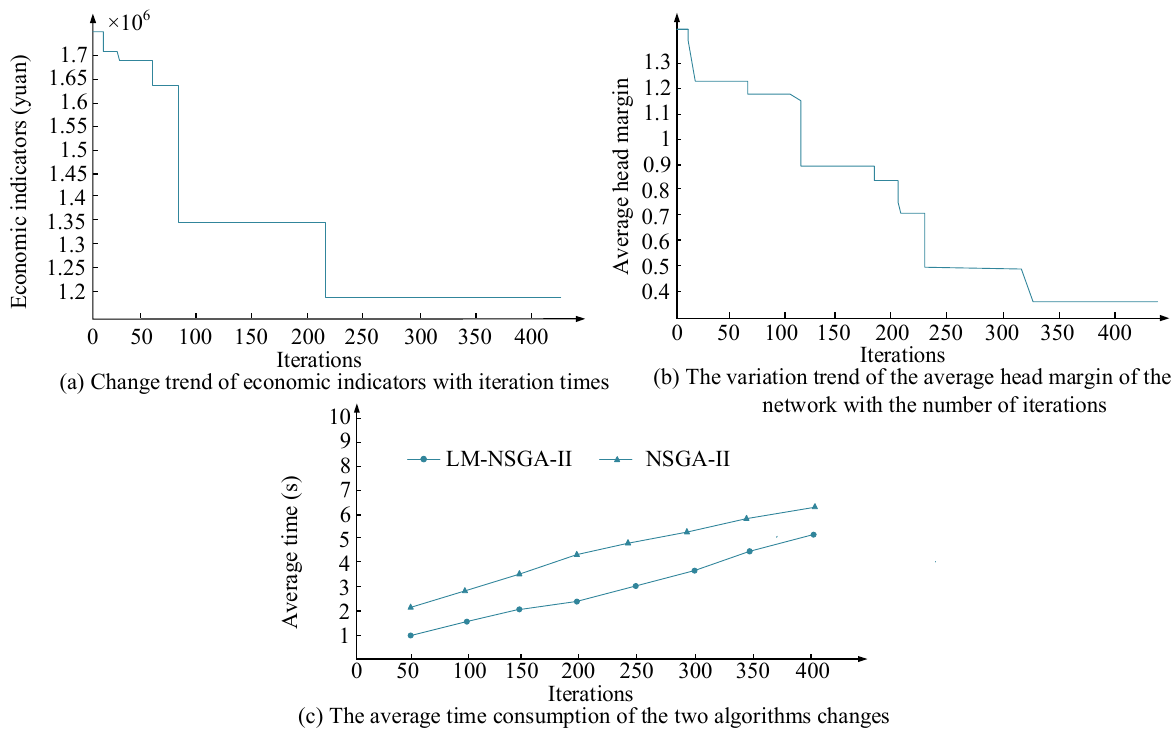
Figure 7. Optimization process of rural water supply pipeline based on LM-NSGA-II algorithm. Table 1. Hydraulic calculation results of multi-objective water supply network.